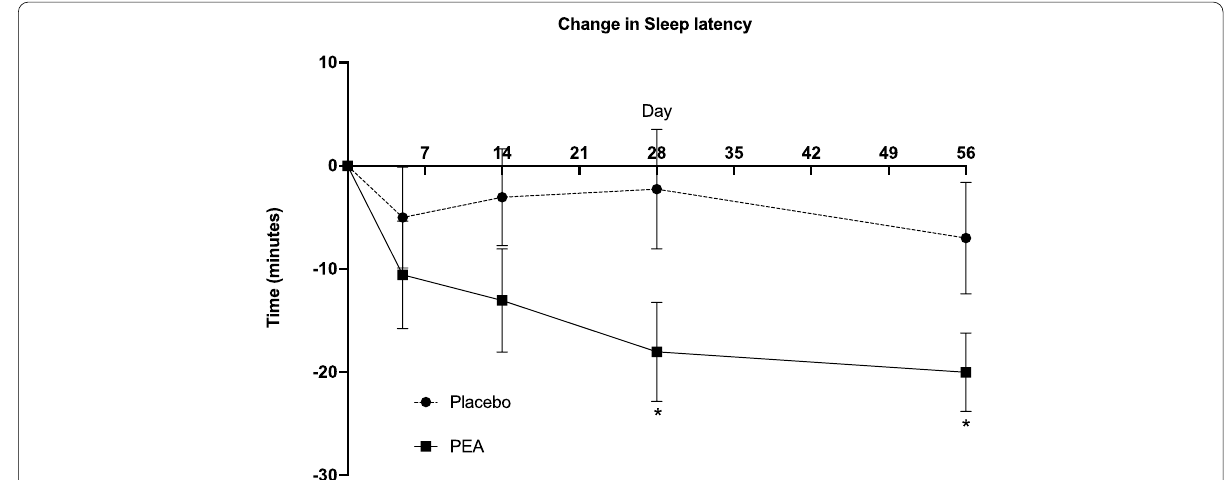
Table 6 Data from sleep questionnaires including domain scores